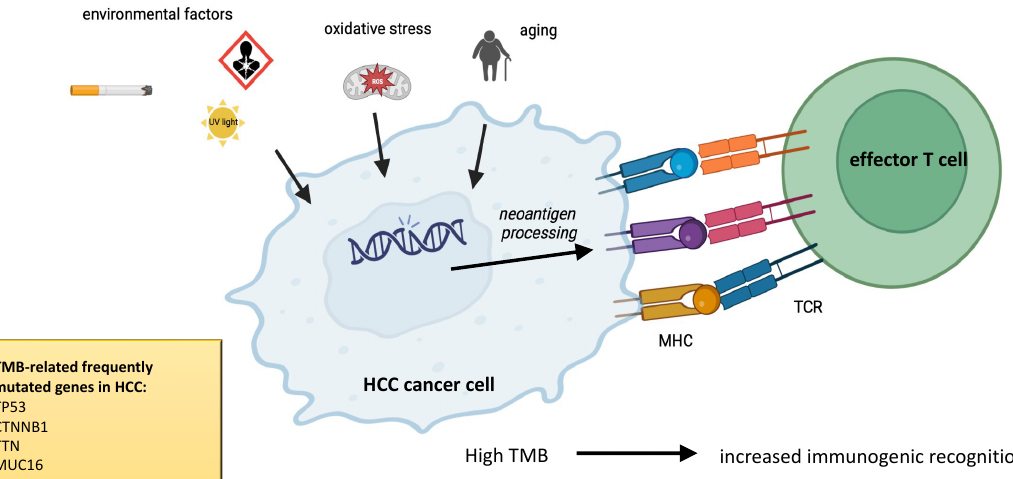
Figure 1. Multiple environmental factors, e.g., UV sunlight, smoke, mutagens, oxidative stress, persistent inflammation, and aging, prompt mutational burden of tumoral cells, increasing neoantigen processing and recognition of neoantigens by effector T cells.